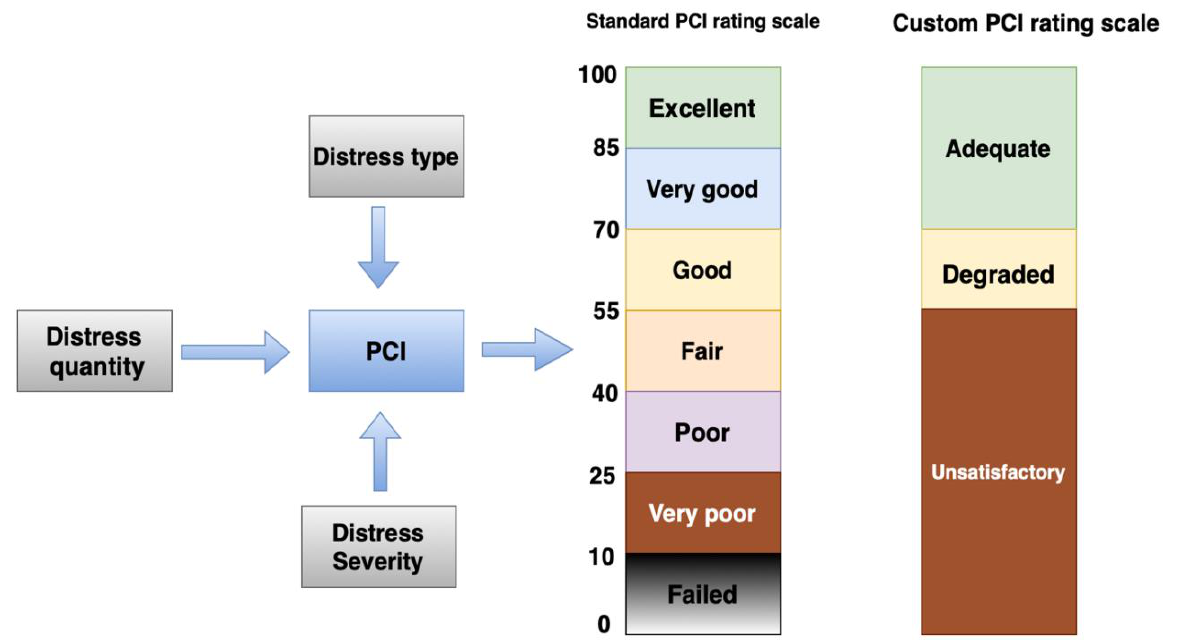
Figure 1. Rating scale used for pavement condition index (PCI) [3].